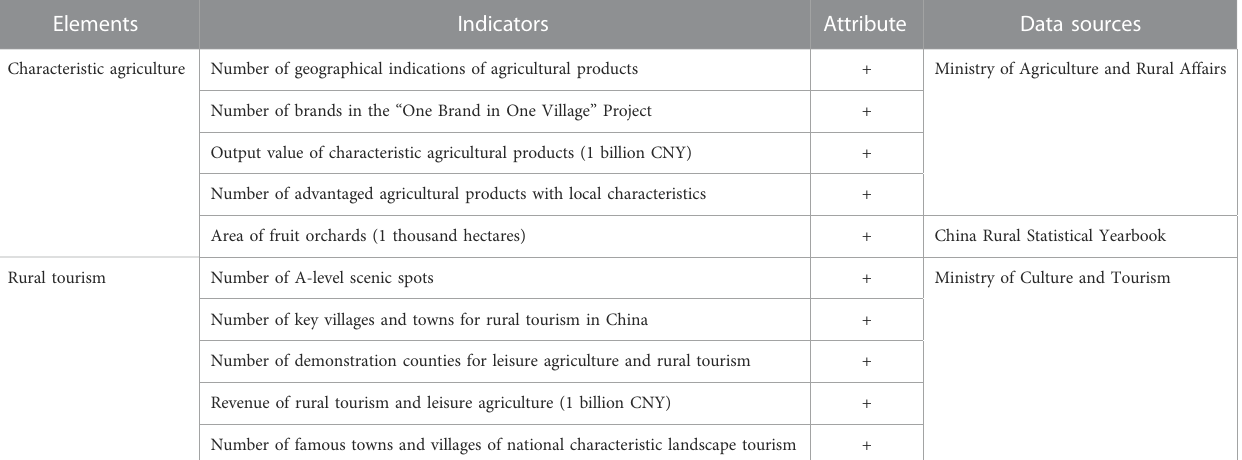
TABLE 2 Indicators for measuring the integration level of agriculture and tourism.